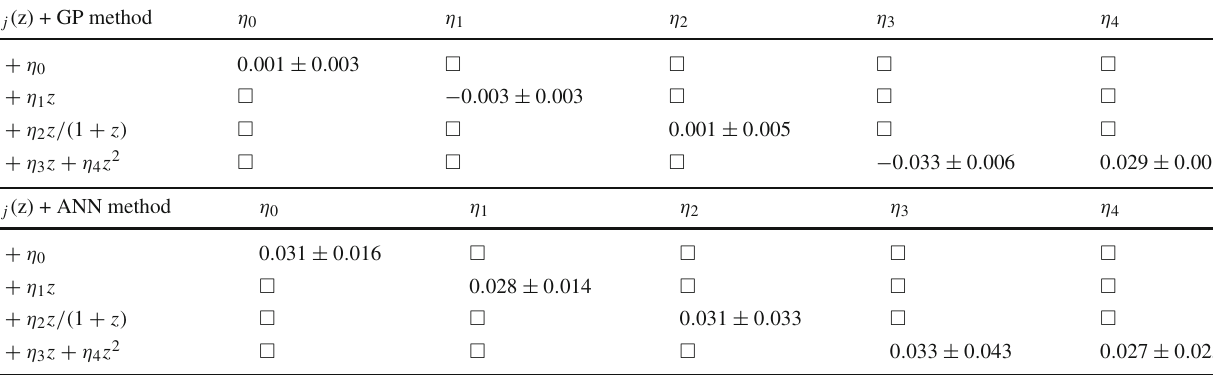
Table 1 Constraints on the CDDR parameters for four types of parameterized forms, in the framework of GP and ANN technologies η j (z) + GP